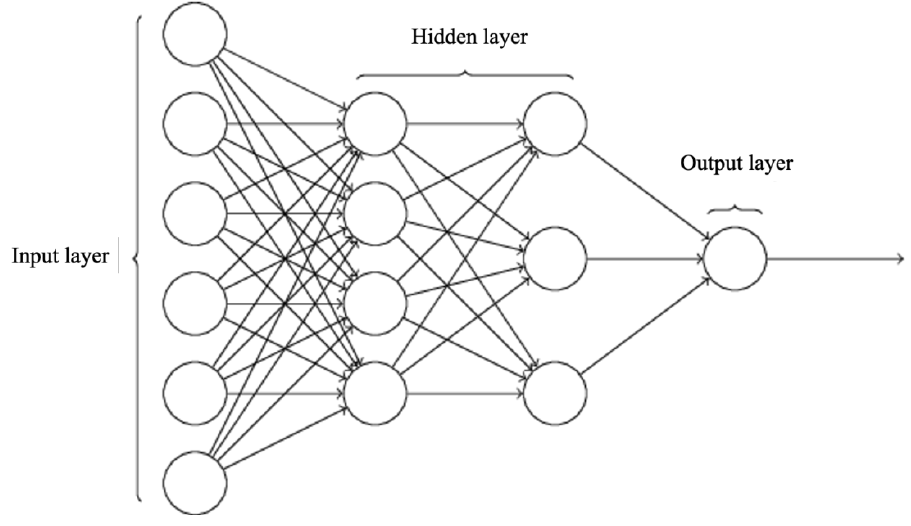
Figure 2. MLP model structure.